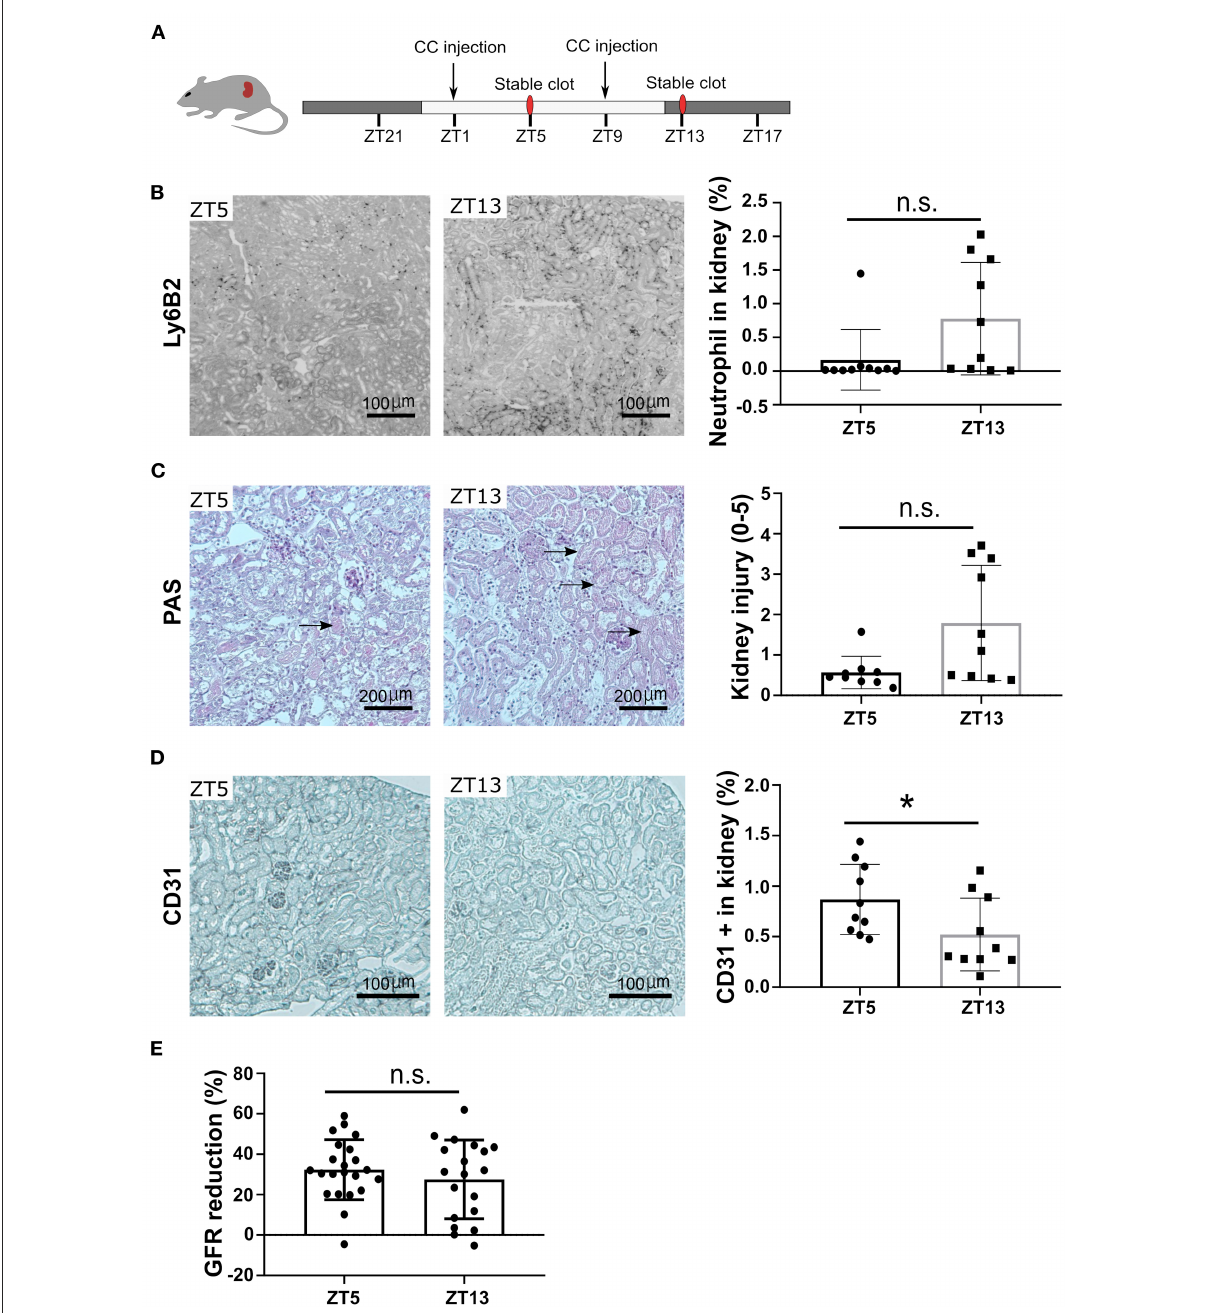
FIGURE4 CC embolism during the active phase leads to more kidney injury. (A) Schematic of experiment. (B) Representative images of Ly6B2 + staining, and neutrophil counts in the kidney at ZT5 and ZT13 ( n = 10 mice/group). (C) Representative images of PAS staining, and mouse kidney injury score at ZT5 and ZT13 ( n = 10 mice/group). (D) Representative images of CD31 staining, and endothelial injury in the kidney ( n = 10 mice/group). (E) GFR reduction upon ZT5 and ZT13 24h post-CC injection ( n = 20 mice/group). While background: daytime, gray background: nighttime. Data are means ± SD , unpaired Student’s t -test, * P < 0.05.